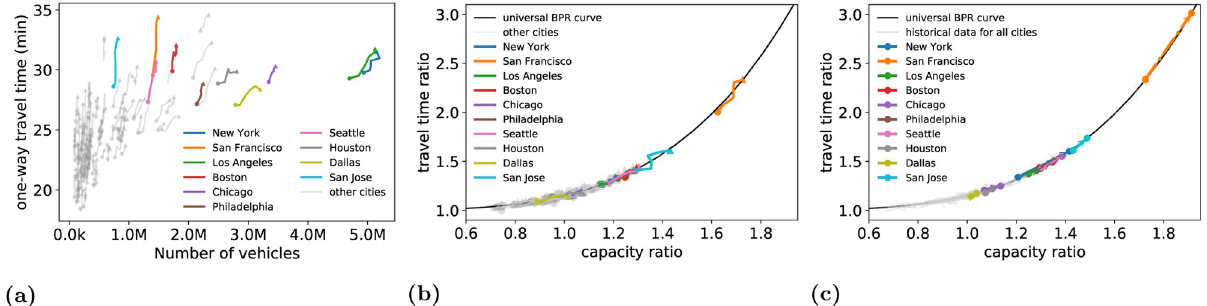
Fig 1. (a) One-way travel time vs. number of vehicles for 118 metro areas in the US from 2013–2018. (b) One way travel time ratio vs capacity ratio for 118 metro areas in the US. Metro areas appear on different portions of a universal BPR curve. For the two end points of each line, the dot denotes the 2013 conditions, while the triangle denotes the 2018 conditions. (c) Metro areas shift along the universal BPR curve under a 25% shift away from transit and carpool to SOVs. Grey lines correspond to all 118 metro areas in the